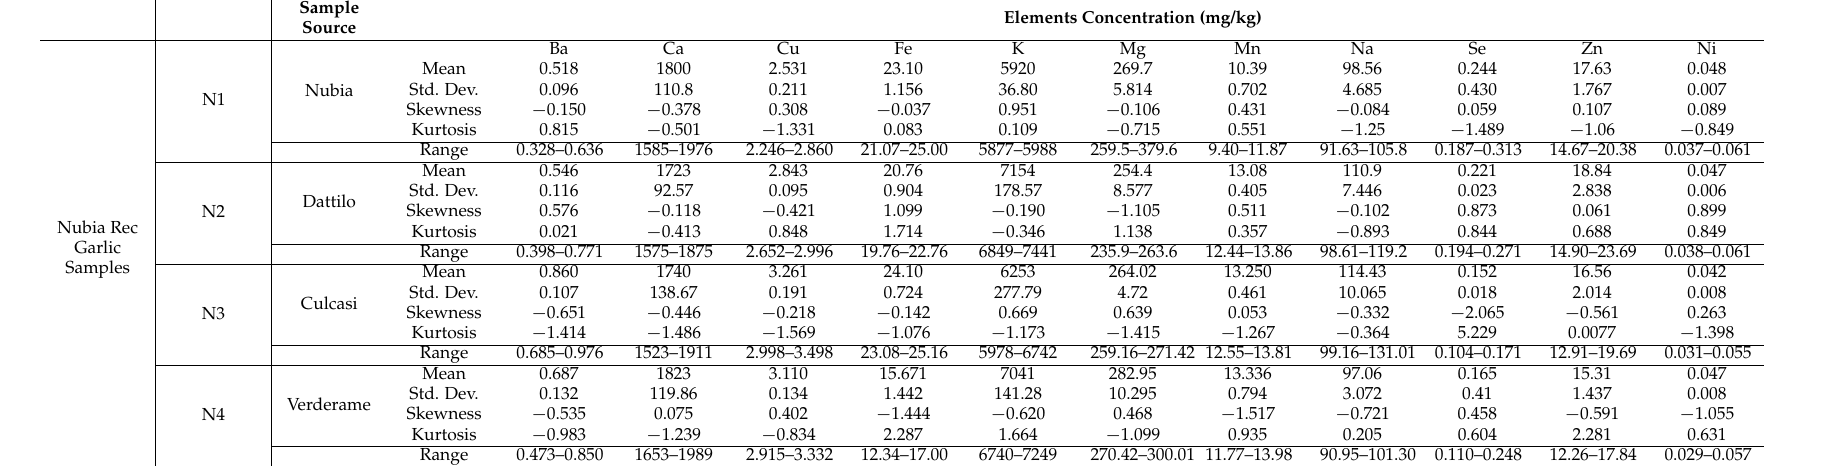
Table 2. General information about the studied garlic